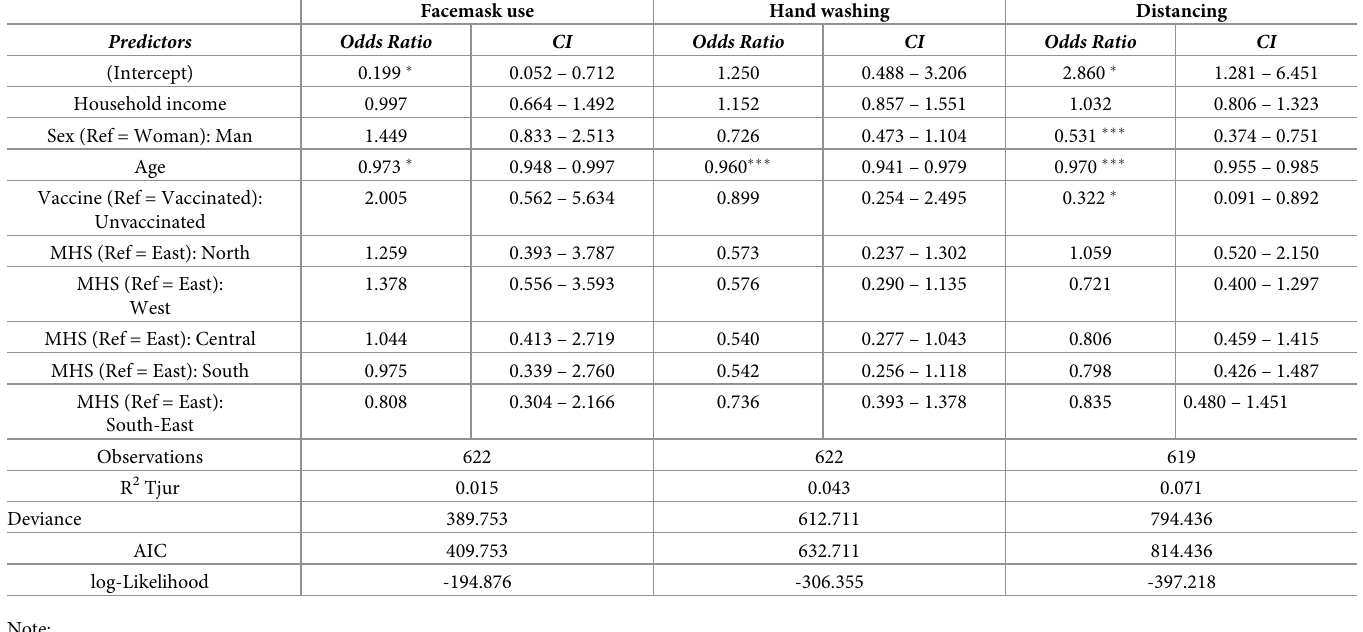
Table 1. Logistic regression models for the change in the COVID-19 personal protection measures (facemask use; hand washing; distancing) between 2020 and august-september